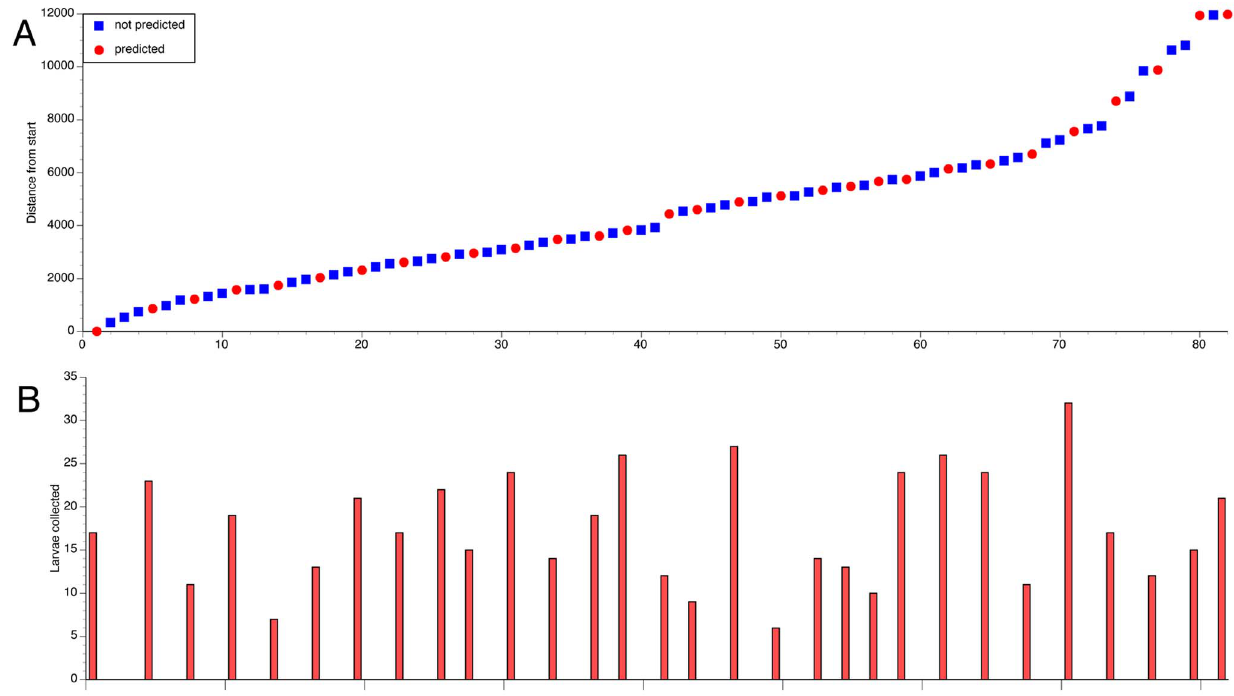
Figure 3. Ground verification of predicted S.damnosum s.l. larval habitats. Panel A: Location of sites surveyed. Locations are presented as the Euclidian distance downstream from the start point of the survey (Lat 445861.2662, Lon 1224410.647). Red circles indicate locations predicted to be breeding sites by the model, while blue squares represent locations of other likely larval sites identified by the survey team as described in the text. Panel B: Larval counts from each survey point. Red bars represent larval counts from sites predicted by the model to represent larval habitats and blue bars (all zero) represent larval counts at the other sites surveyed.